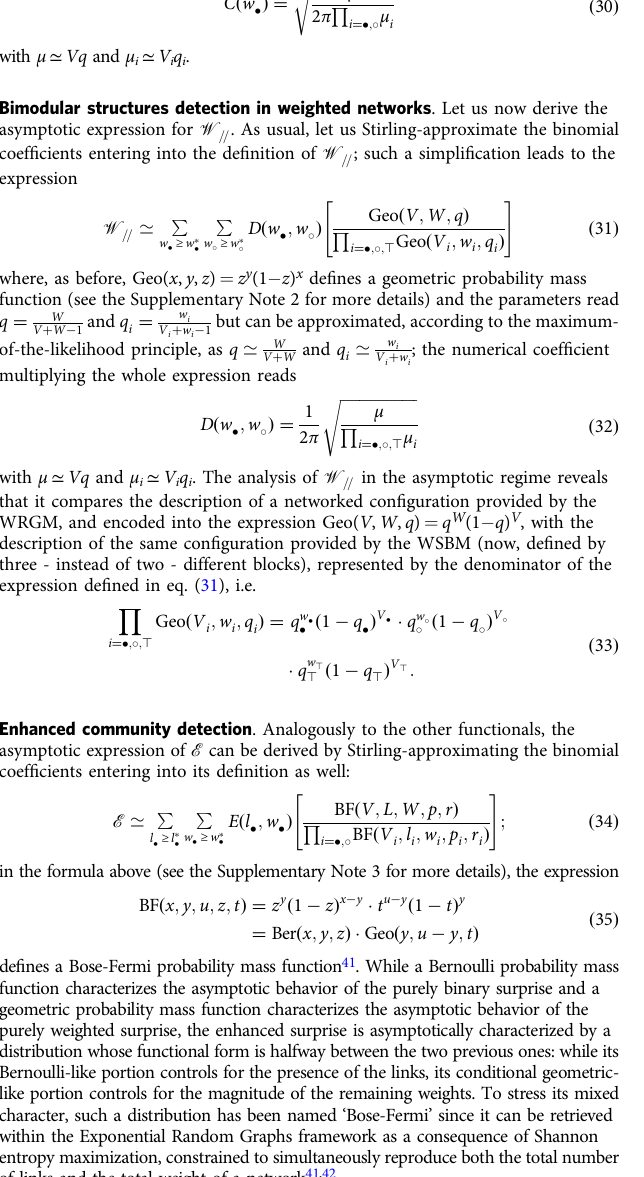
ffiffiffiffiffiffiffiffiffiffiffiffiffiffiffiffiffiffiffiffiffiffi μ